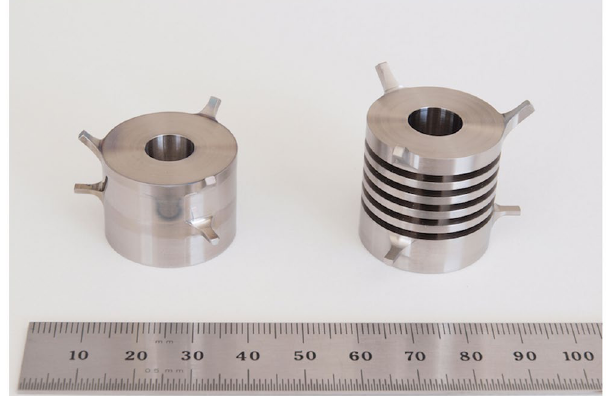
Figure 1. Photograph of the two sinkers for the sorption studies. Left: the “density sinker”, which was located at the top of the measuring cell; right: the “sorption sinker”, which was located at the bottom of the measuring cell. The top set of “pins” on each sinker were engaged by the “lifting fork” of the sinker changing mechanism, and the bottom set of pins engaged a “sinker rest” when it was not being weighed. (See Fig. 6 for a schematic diagram of these sinkers installed in the measuring